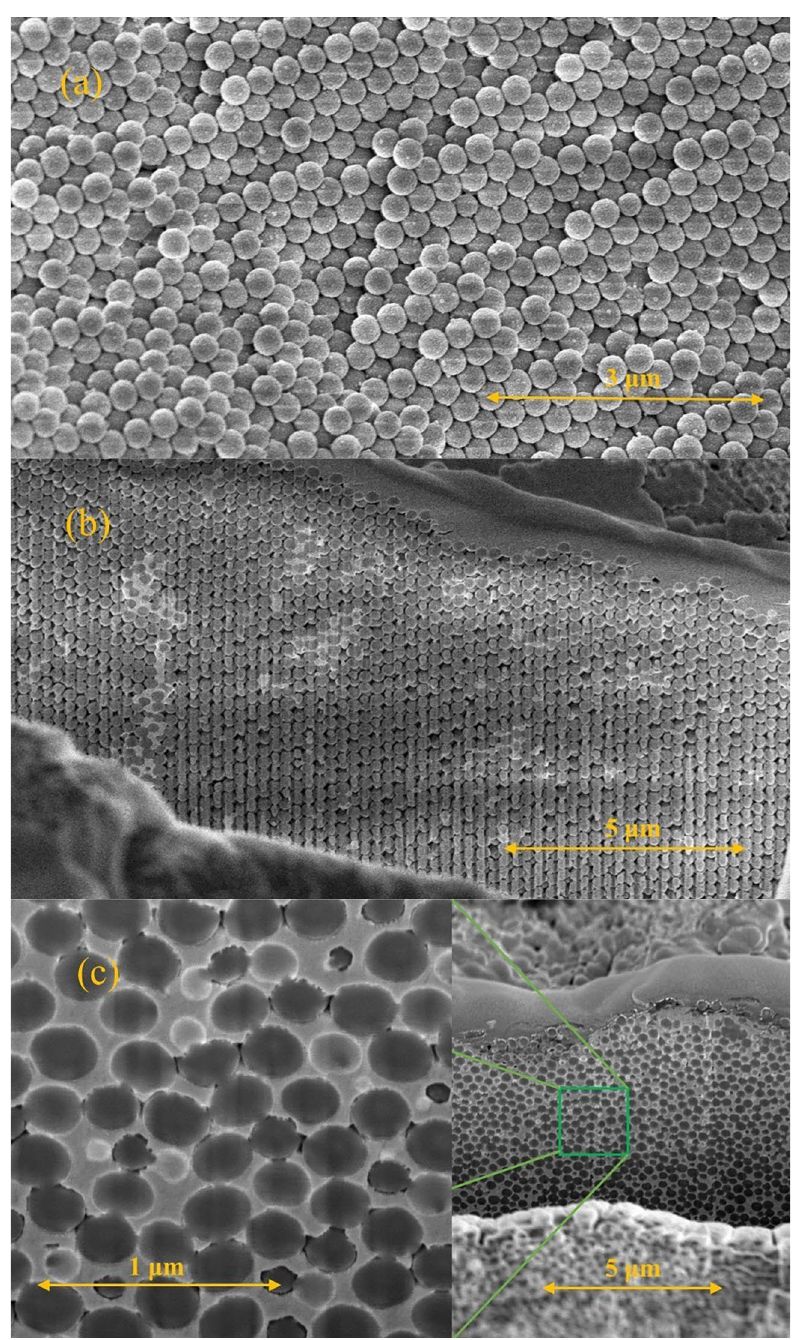
Figure 1. SEM images of opal nanocomposites with scales. ( a ) A micrograph for O-In on the surface, there is almost no any indium in pores indicating a very low filling factor near surface. The small particles on silica spheres are platinum (to improve SEM image). ( b ) The cross section of O-In milled by the Ga ion beam; pores are partially filled by indium. ( c ) The cross section images of O-Sn, all pores are almost filled by tin. On the left side, we show an enlarged